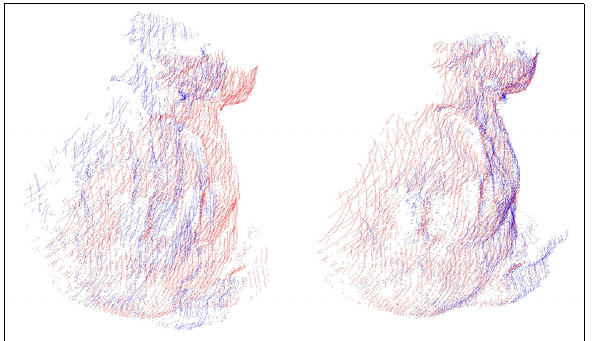
Figure 7: Point clouds before and after approximate registration.